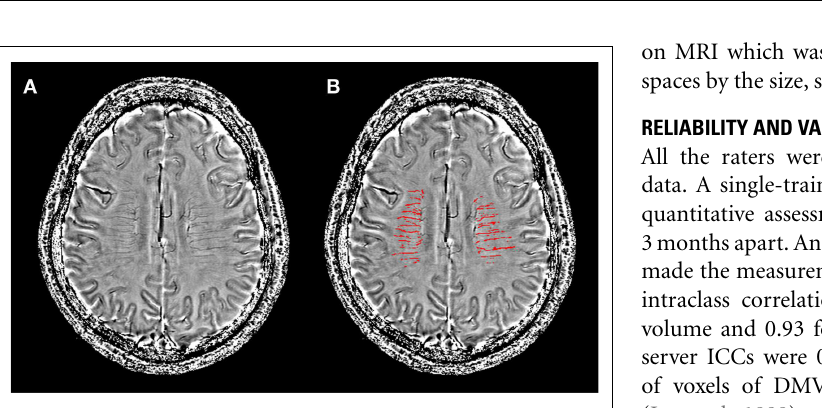
FIGURE 1 |AxialT2 fluid attenuated inversion recovery (FLAIR) images were coregistered to the phase images . (A) T2 FLAIR image; (B) phase image of the same patient was set as a reference; (C) coregisteredT2 FLAIR image.